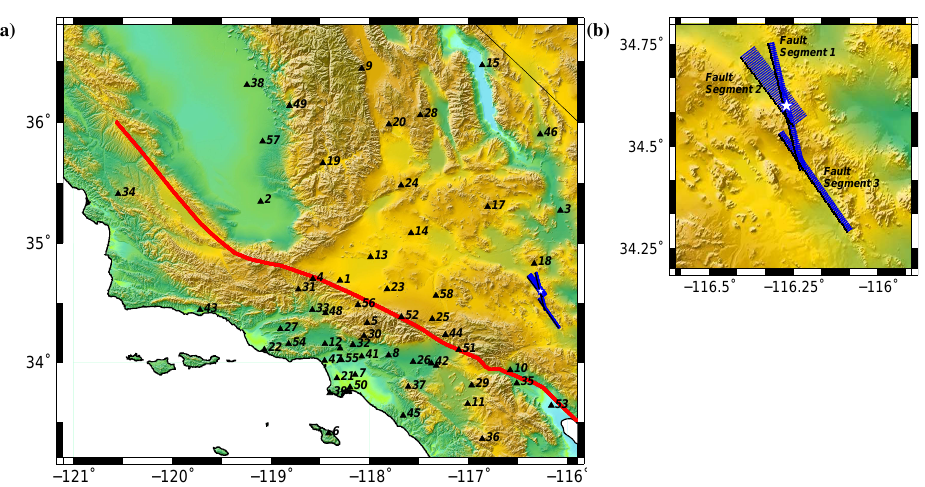
Figure 5. ( a ) Location of all stations used in the 1999 Hector Mine earthquake validation. Red line: Southern section of the San Andreas fault extending from Parkfield in central California to Bombay Beach in southern California. Blue line: Surface projection of the [49,50] source model. Star: Epicenter. Black triangles: Stations ( b ) Fault segments in the model. Blue line: Surface projections. Black line: Surface trace. Star: